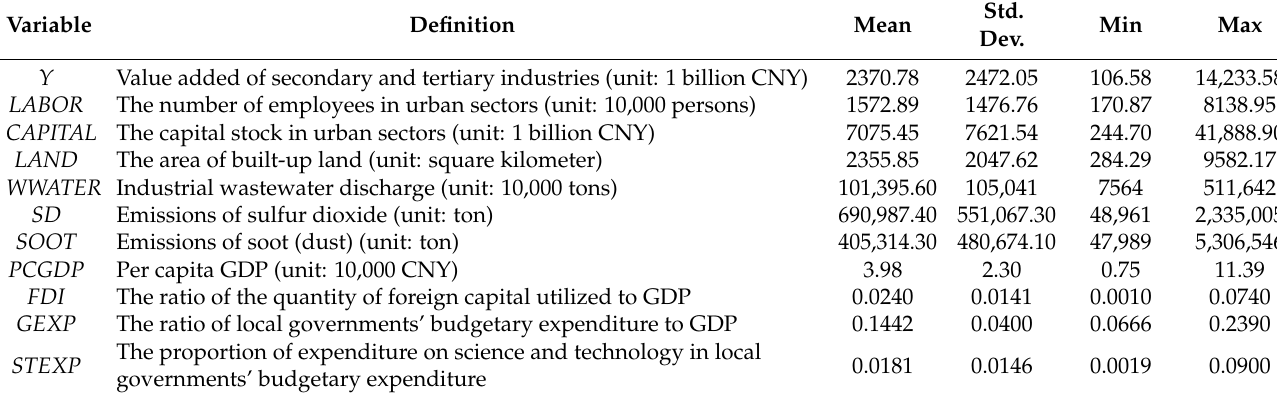
Table 1. Variable definitions and summary